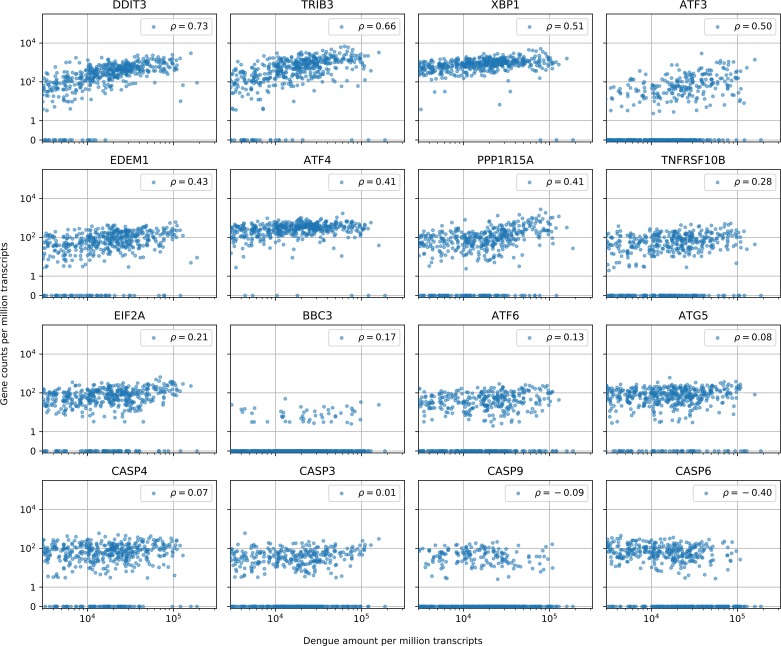
Cells with the highest intracellular DENV amounts show clear signs of prolonged ER stress response but no obvious sign of increased apoptosis.In cells with more than 1000 virus reads per million transcripts, expression of clear effectors of apoptosis (e.g. caspases) does not show a strong correlation with virus amounts - CASP6 actually shows a negative correlation -, but DDIT3/CHOP and its downstream targets TRIB3 and PPP1R15A/GADD34, which are usually assumed as mediator of apoptosis, all show distinctive upregulation in cells with large intracellular virus amounts (Sano and Reed, 2013; Szegezdi et al., 2006). Positive regulator of apoptosis BBC3/PUMA shows a modest correlation of 0.17. Genes are sorted by correlation with intracellular DENV amount.